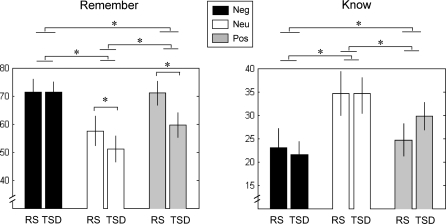
Behavioral DataPercentage of correctly remembered and known images as a function of sleep groups. RS: regular sleep, TSD: total sleep deprivation, Neg: negative, Neu: neutral, Pos: Positive.